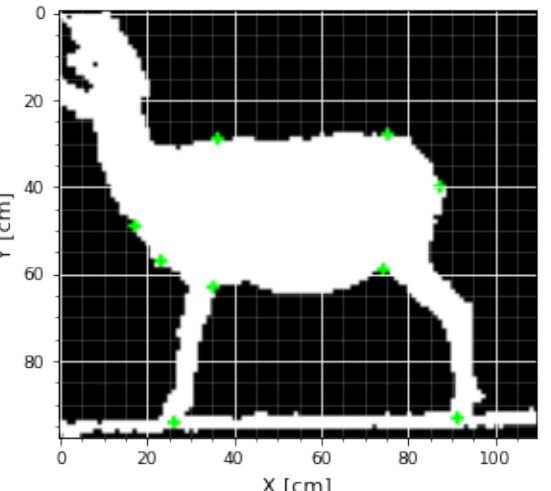
Figure 9. Interface where the user places the points of interest to generate the measurements.